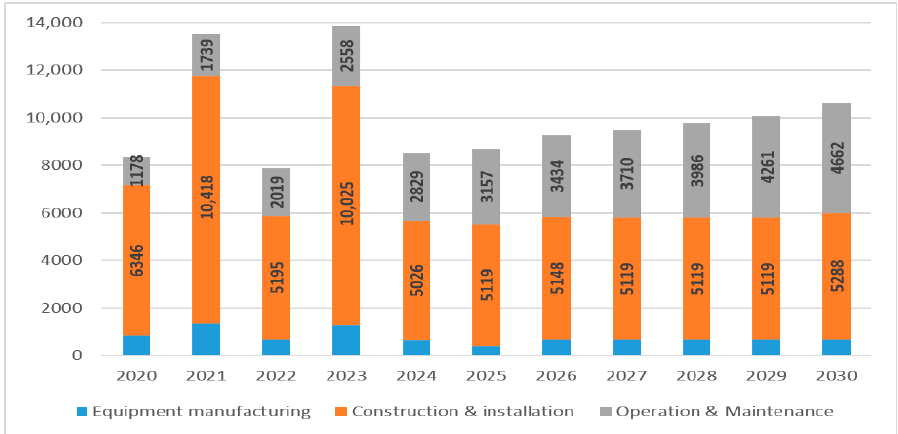
Figure 8. The projected employment at household and energy cooperative solar installations in